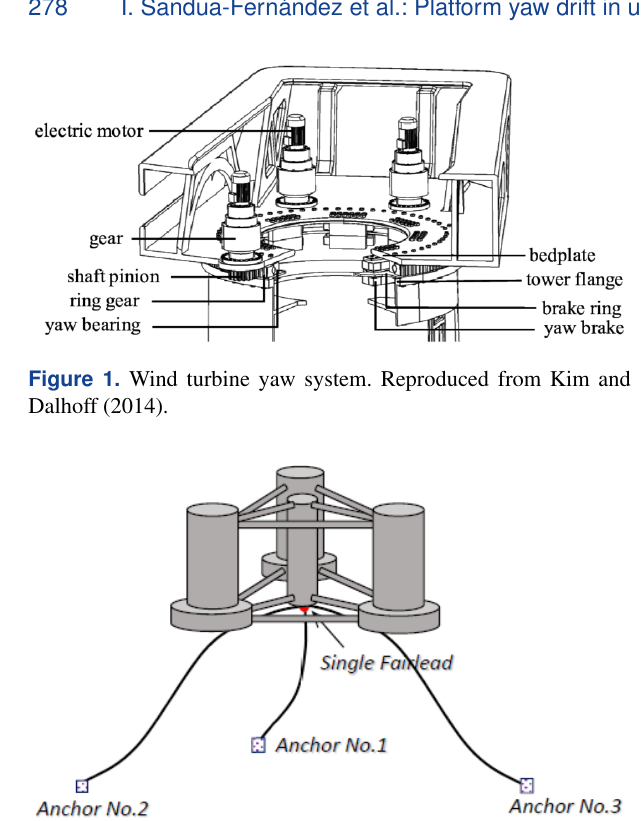
Figure 2. Floating platform with an SPM configuration. Repro- duced from Liu et al.